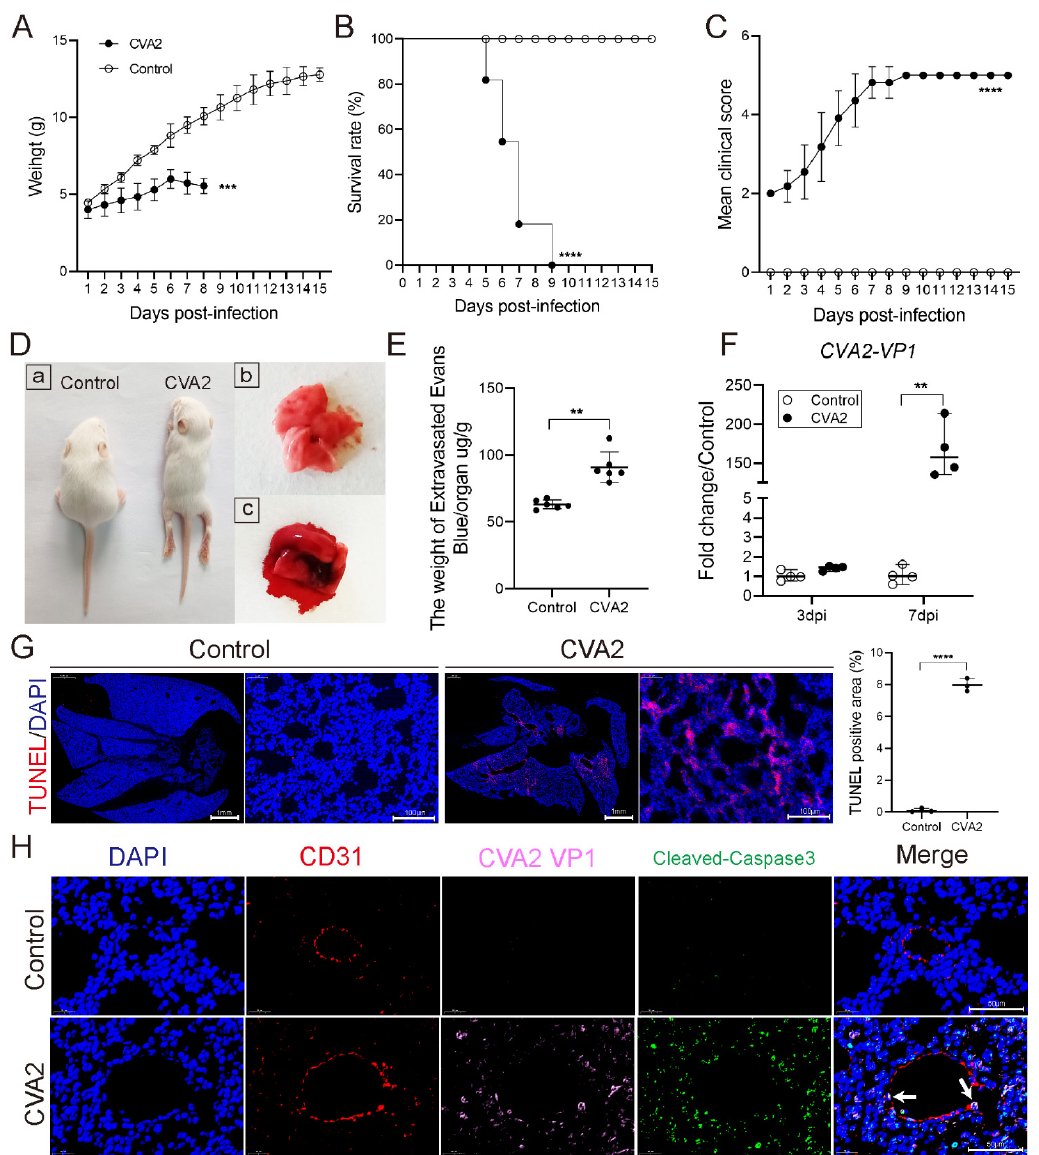
Figure 1. CVA2 infection led to acute lung injury in mice. ( A – C ) Body weights, survival rates, and mean clinical scores of mice in the experiments under optimized conditions (dosage (10 4 TCID 50 /mouse), inoculation route (intramuscularly), and age (5-day-old BALB/c mice)) were monitored and recorded daily after inoculation with CVA2 until 15 dpi. Control animals were administered with equal culture medium ( n = 10 per group). ( D ) Clinical manifestations of mice after CVA2 infection at 7 dpi. ( D ( a )): The representative clinical signs (weight loss, reduced mobility, ataxia, and single or double hind limb paralysis) induced by CVA2 infection in mice. The control mice treated with medium were healthy throughout the experiment. ( D ( b )): Normal lung tissue from control mouse. ( D ( c )): The lung tissue from CVA2 infected mouse (dark red with obvious bleeding and enlargement). ( E ) EB extravasation assay was performed to detect the pulmonary vascular permeability expressed as the ratio of EB content ( µ g) to the wet weight (g) of the lung tissues ( n = 6 per group). ( F ) The relative expression of CVA2 VP1 mRNA was detected by qPCR ( n = 4 per group). ( G ) TUNEL assay detected lung apoptosis at 7 dpi by immunofluorescence assay ( n = 3 per group). ( H ) Colocalization of CD31, CVA2 VP1 and Cleaved-Caspase3 in lungs at 7 dpi was observed by immunofluorescence assay. The white arrows indicated cells with three proteins colocalization. Data represent the mean ± the standard error or median with range. ** p < 0.01; *** p < 0.001; **** p < 0.0001 vs. control. All experiments were repeated three